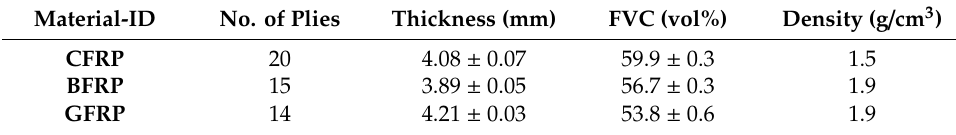
Table A1. Physical properties of carbon, glass and basalt fiber reinforced polybenzoxazines.